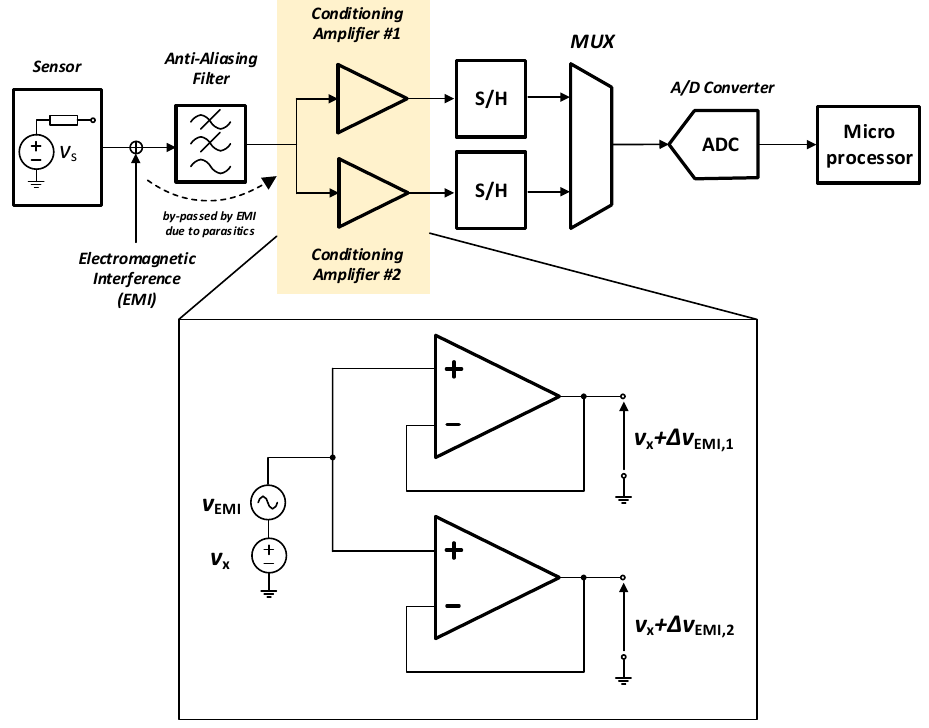
Figure 2. New Acquisition Front-End Architecture aimed to compensate EMI-induced distortions due to EMI rectification by digital